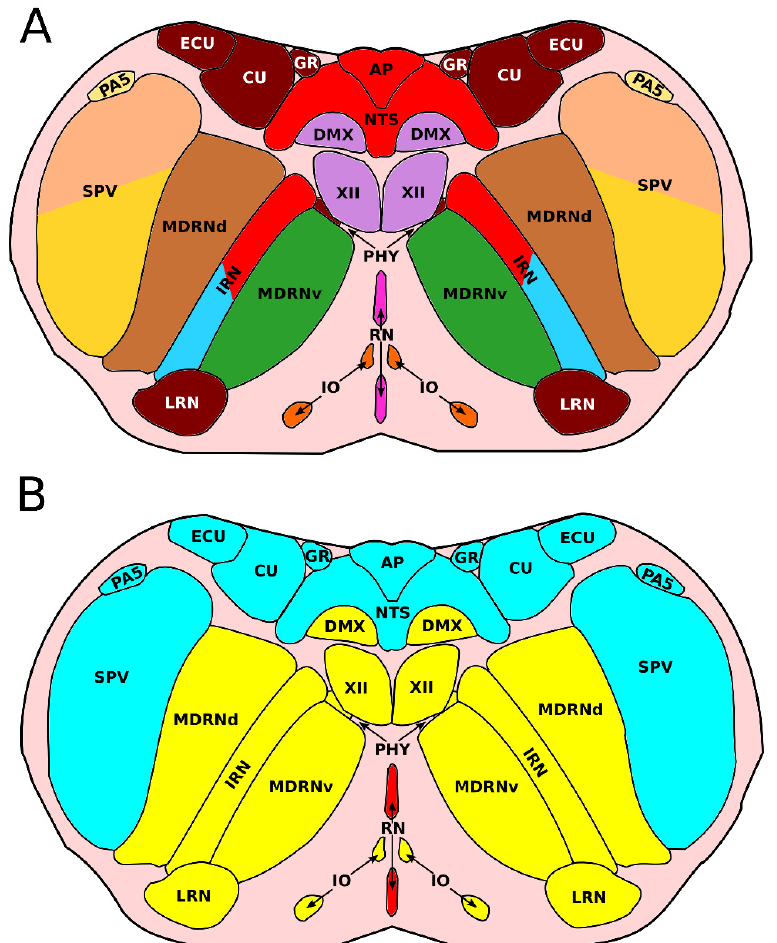
Figure 5. Location of the medullary nuclei in the caudal adult medulla oblongata (r10–r11). ( A ) Location of the medullary nuclei in the caudal adult medulla oblongata. Colors of the nuclei correspond to the colors used as in Figure 3. ( B ) Overview of the location and overall function of the medullary nuclei in the rostral adult medulla oblongata. Nuclei with a sensory function are depicted in blue, nuclei with a motor function are depicted in yellow, and nuclei with a behavioral function are depicted in red. Overviews are based on anatomical reference atlases from the Allen brain institute [43].